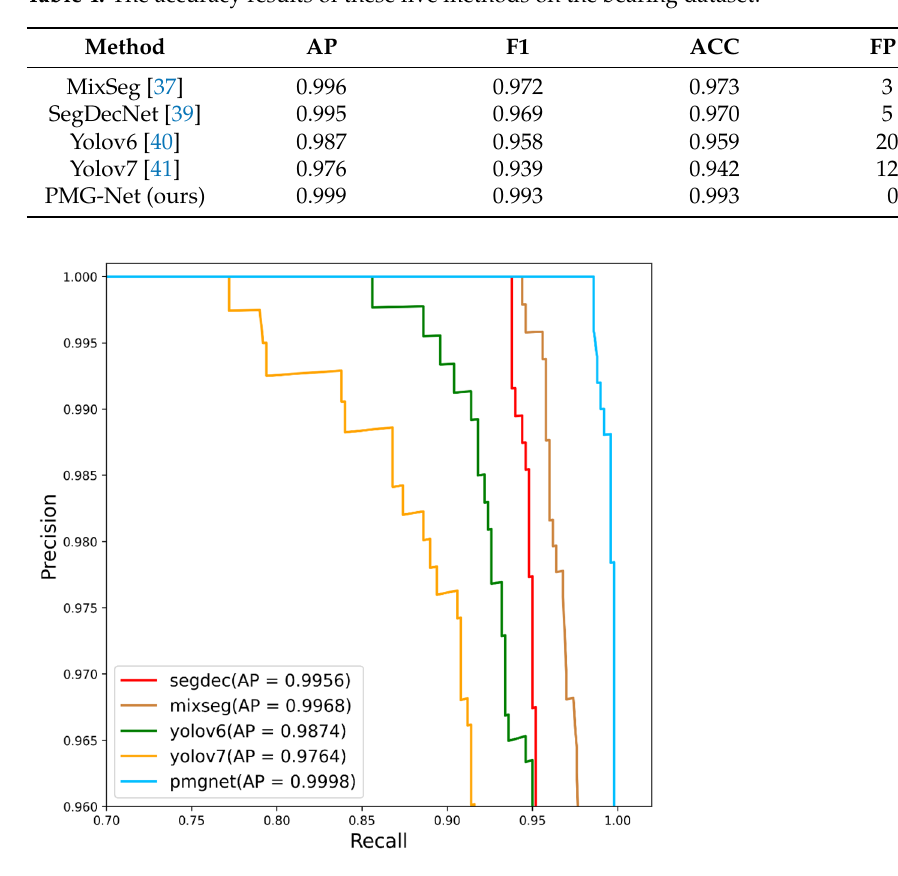
Figure 10. AP curve of different defect detection methods. Table 4. The accuracy results of these five methods on the bearing dataset.